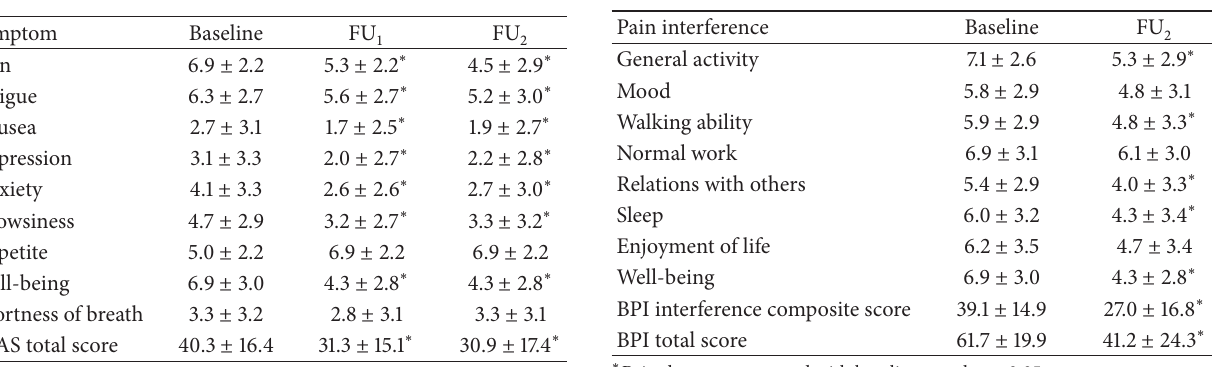
Table 3: Other symptoms ratings as per ESAS.